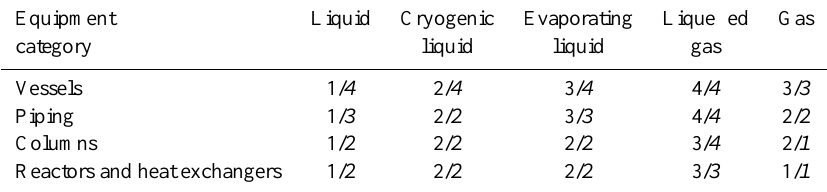
Table 4. Critical equipment and associated technological hazard index for events triggered by earthquakes and lightning (in italic).